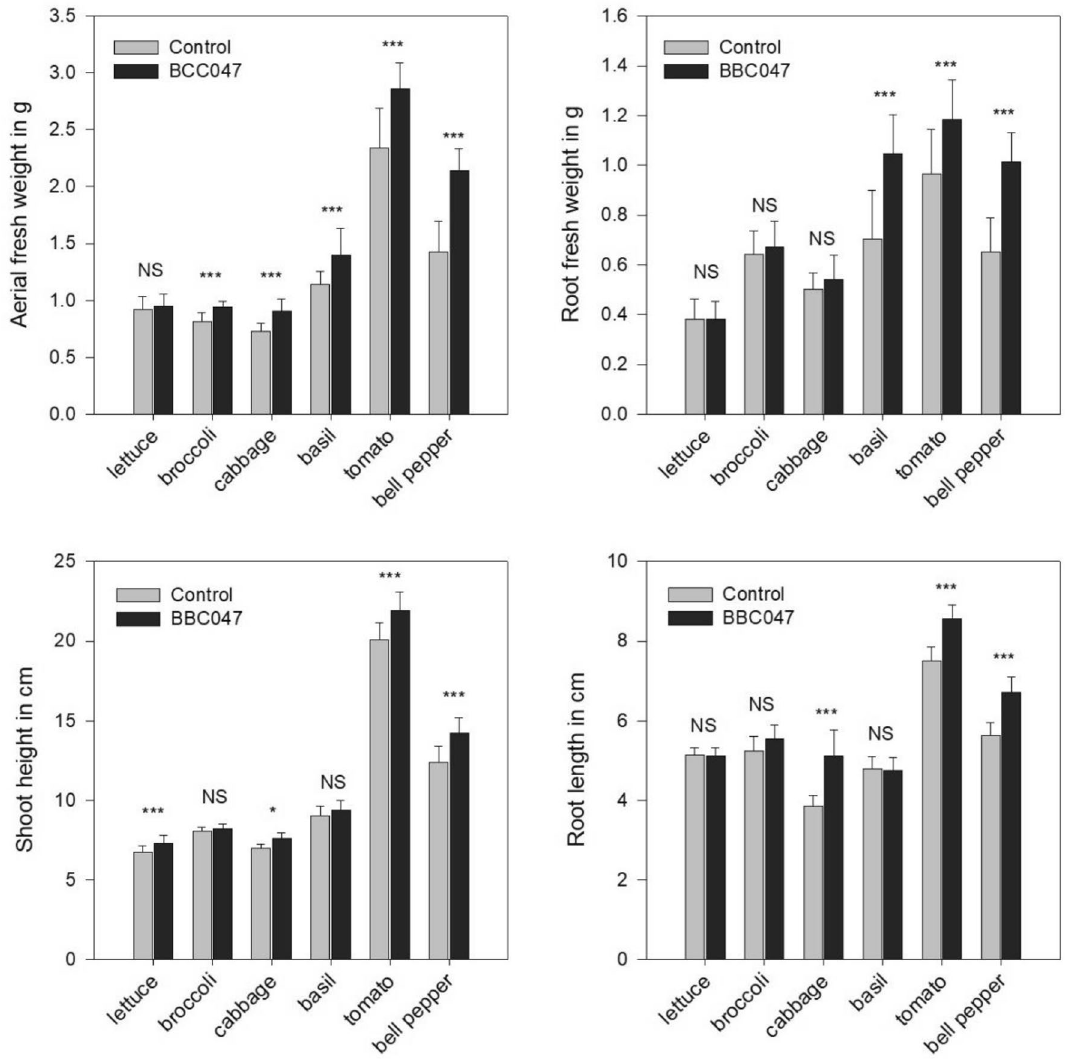
Figure 1. Effect of B. velezensis BBC047 application on five crop seedlings in horticulture nursery (at age of transplant, N = 20). Measured parameters: aerial fresh weight, root fresh weight, shoot height and root length. Statistical difference determined with ANOVA (* p < 0.05; *** p < 0.001; NS = not